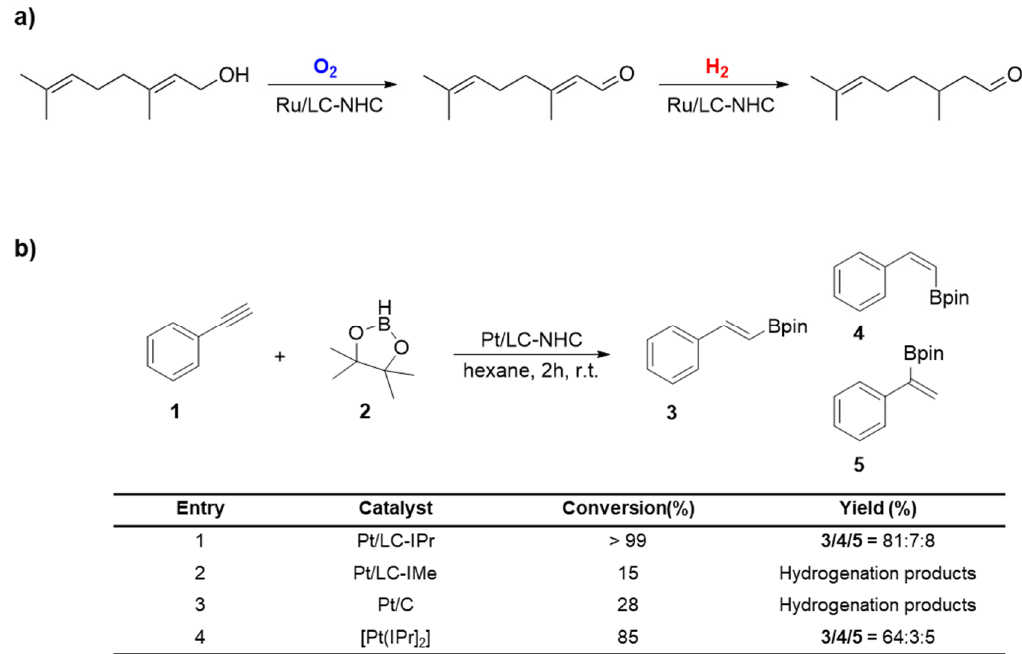
Figure 19. ( a ) One-pot oxidation-hydrogenation of geraniol catalyzed by Ru NPs stabilized with LC-NHCs. ( b ) Hydroboration of phenylacetylene catalyzed by Pt stabilized with LC-NHC. Adapted with permission from reference 23. Copyright 2017 Wiley-VCH.